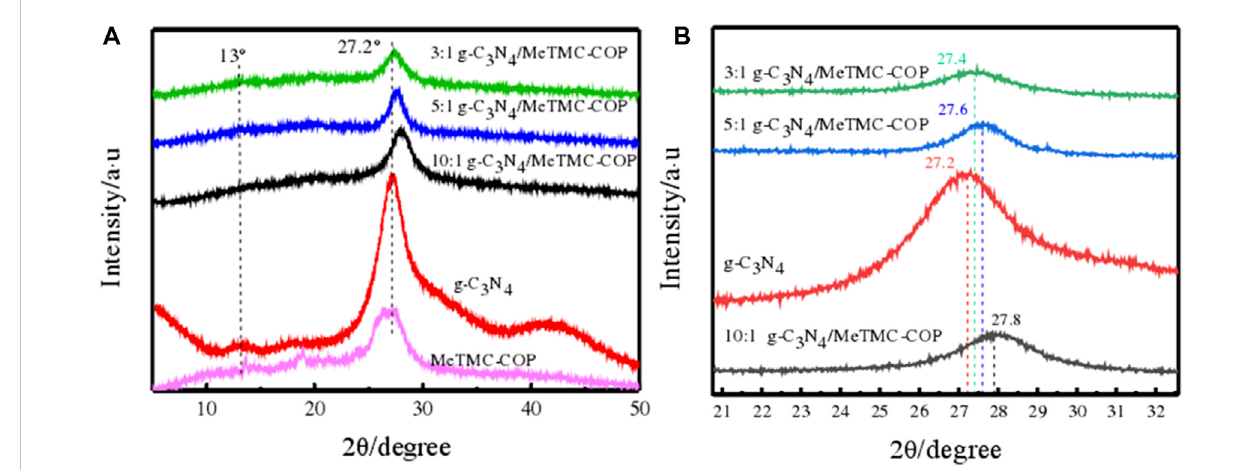
FIGURE 3 XRD patterns (A) and partial enlarged images (B) of different ratios of g-C 3 N 4